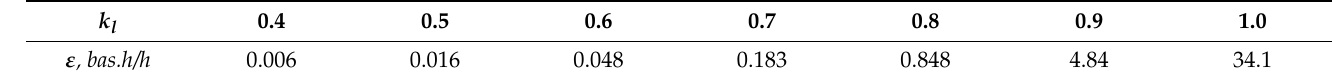
Table 2. Dependence ε = f ( k l ) at x = 1, k u = 0.9.